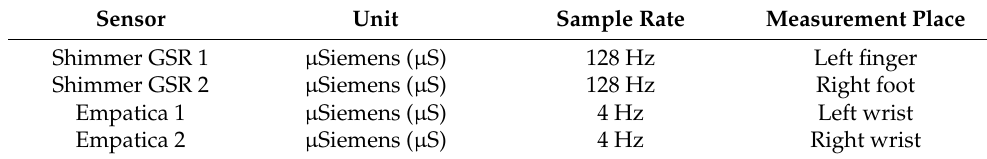
Table 2. Sampling characteristics of the sensors and their place of measurement.